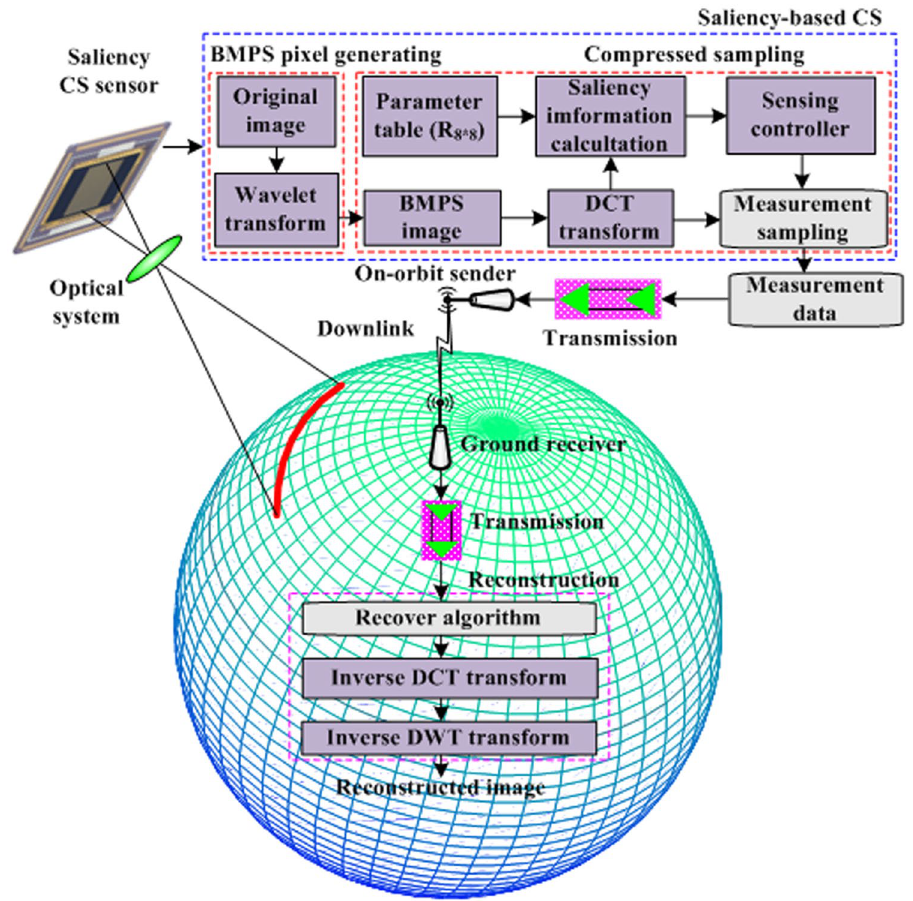
Figure 1. Overall architecture of the proposed PTFS-CS